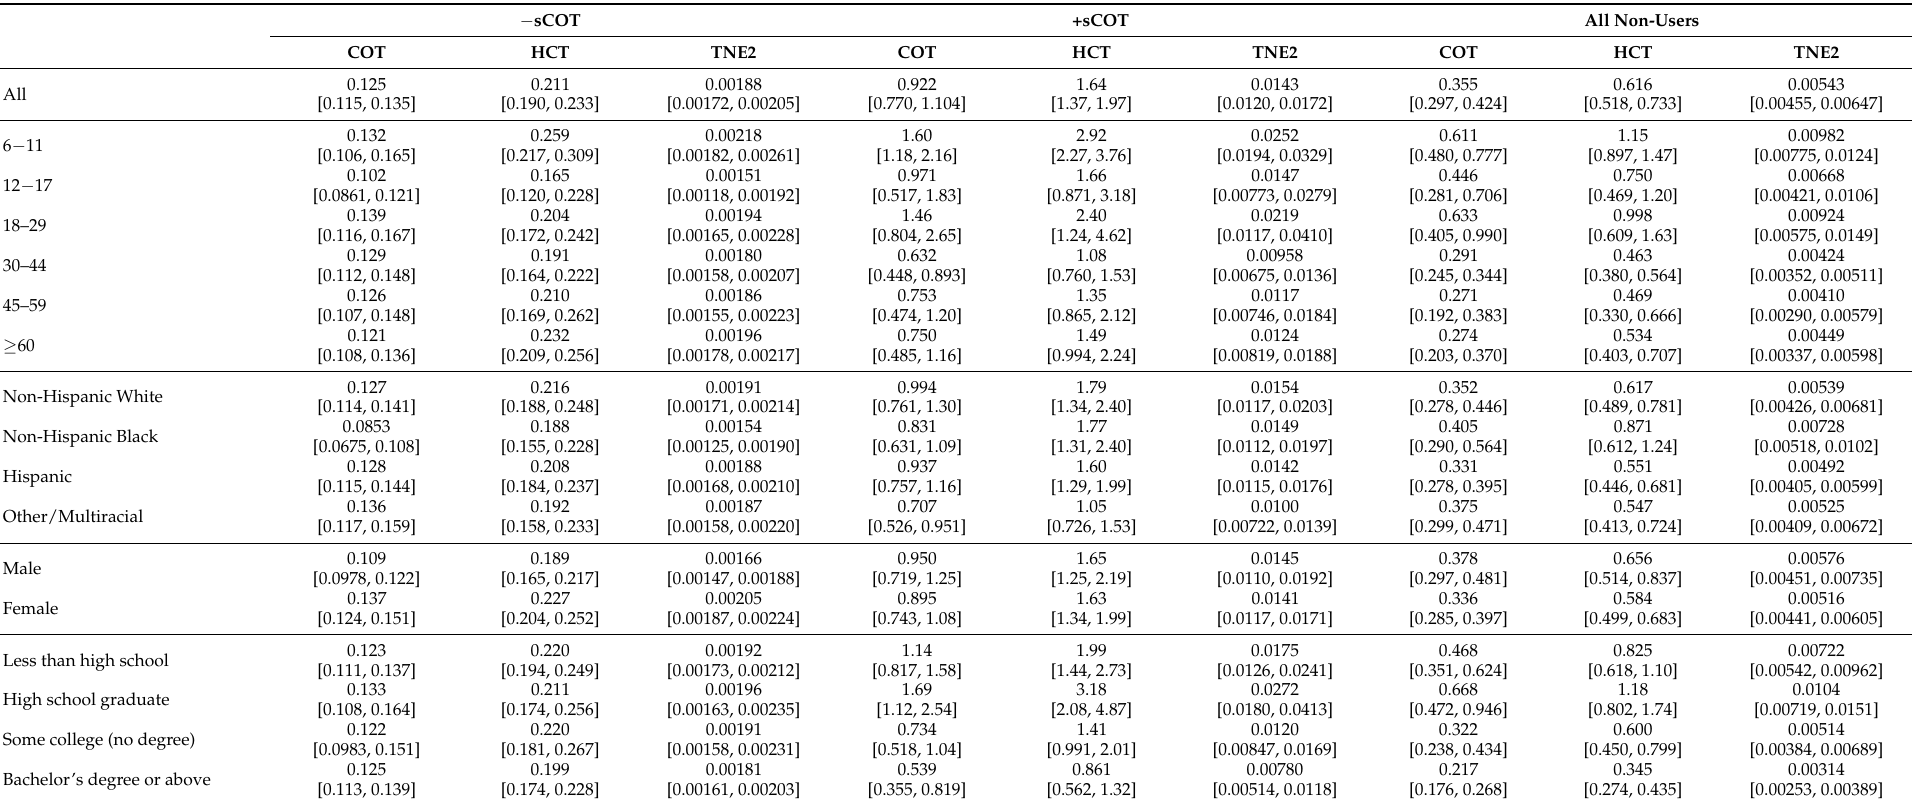
Table 2. Sample-weighted creatinine adjusted geometric mean for cotinine, trans-3 (cid:48) -hydroxycotinine ( µ g/g creatinine) and TNE2 ( µ mol/g creatinine), with 95% confidence interval, among non-users, from NHANES 2015–2016. − sCOT +sCOT All